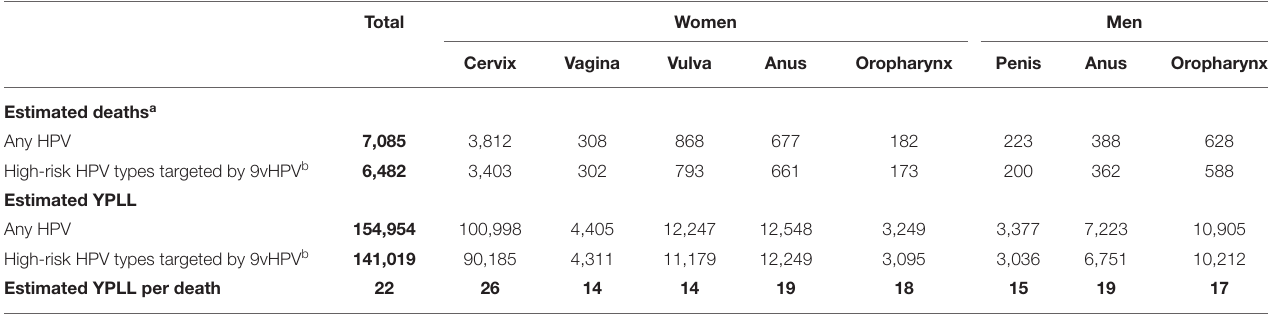
TABLE 3 | Estimated number of HPV-attributable cancer deaths in the United States in 2017 and estimated YPLL associated with HPV-attributable cancer stratified by sex and HPV type.